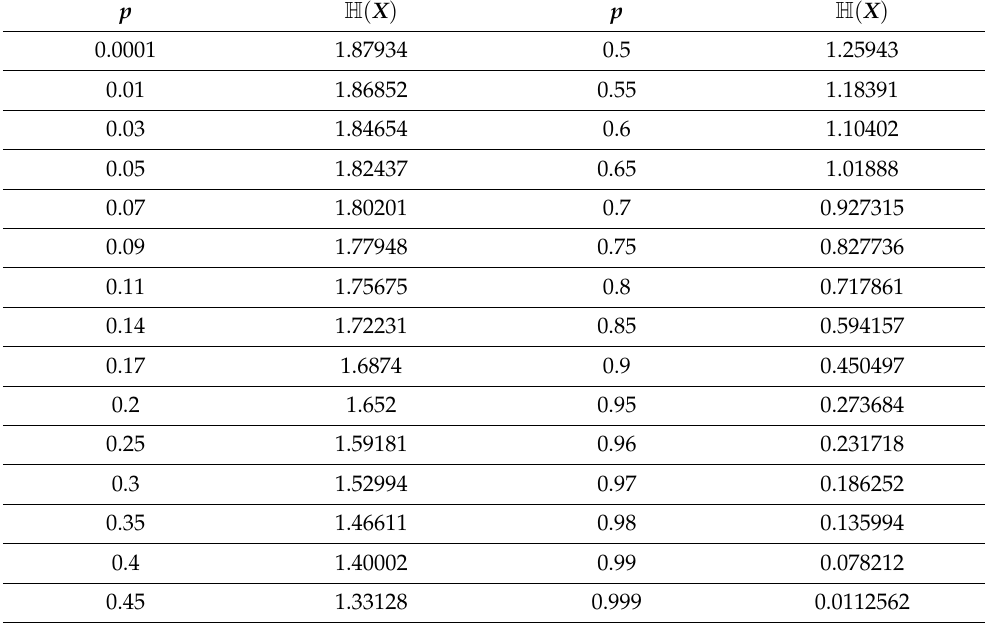
Table 2. Numerical results of H ( X ) for different values of the parameter p